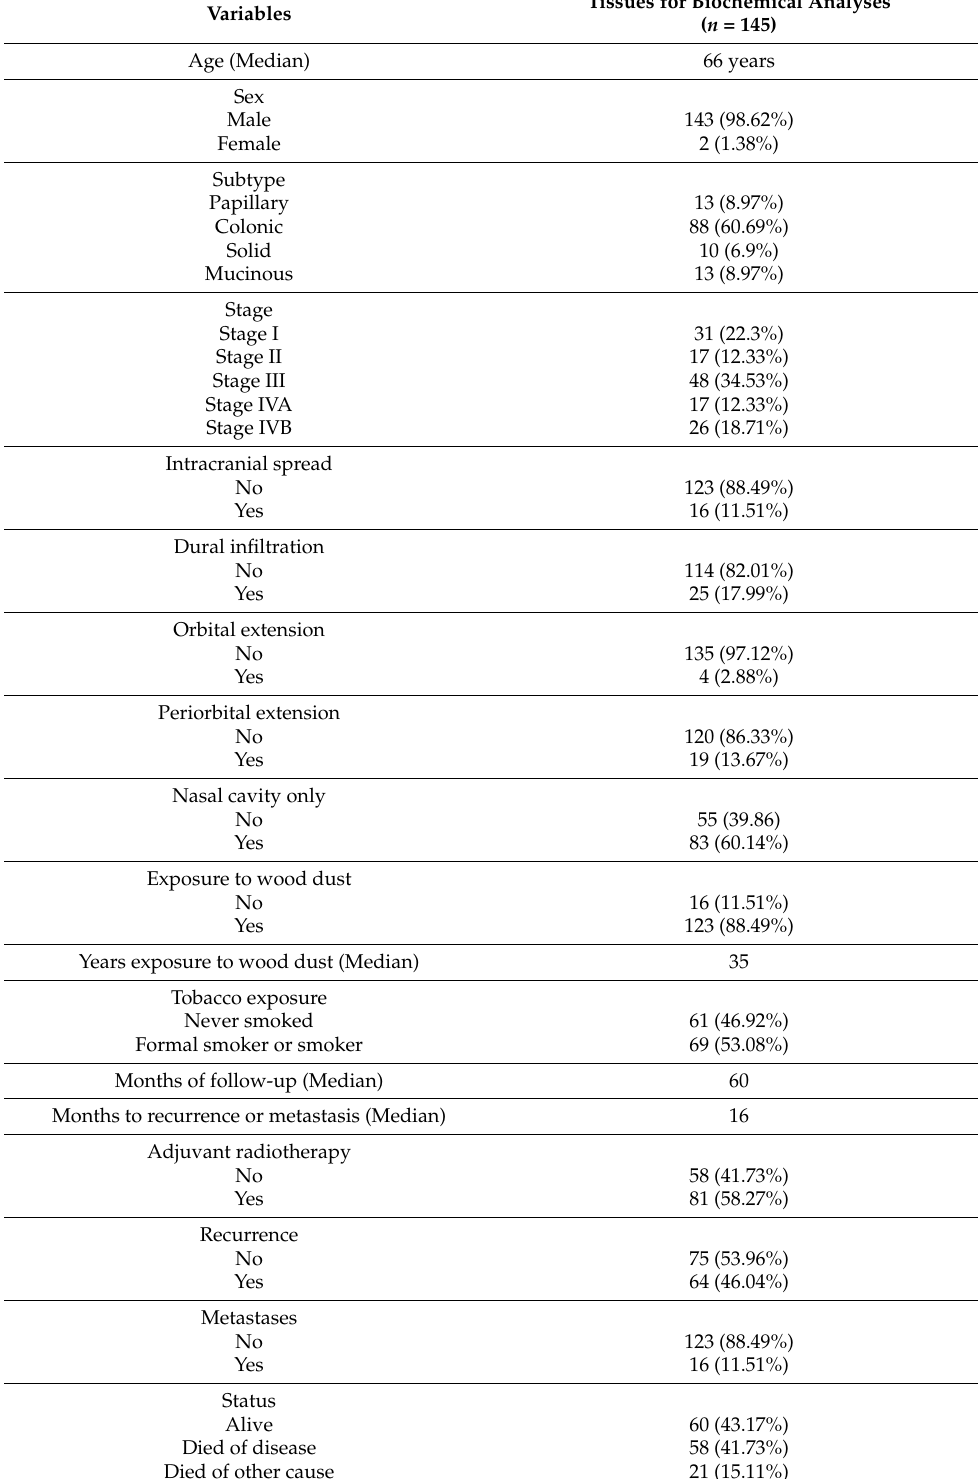
Table 1. Clinical data of patients’ tissues. For control NNT from the patients were